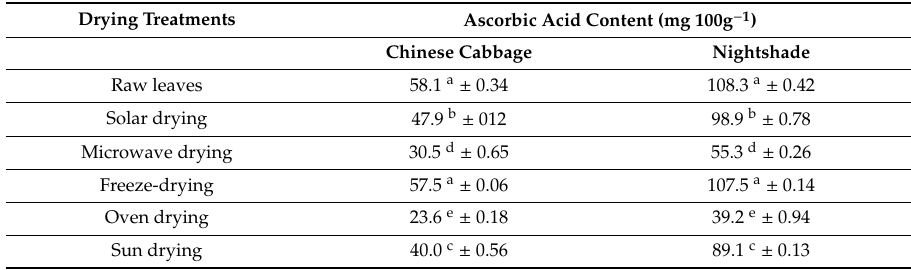
Table 10. E ff ect of drying treatments on ascorbic acid content in Chinese cabbage and Nightshade